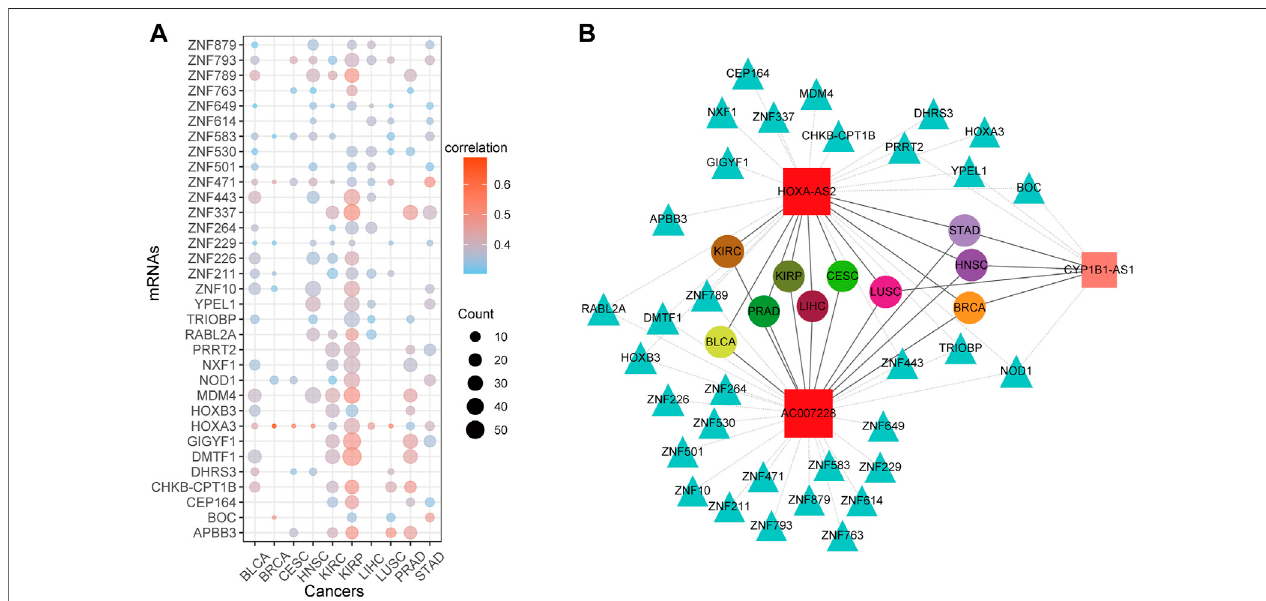
FIGURE 9 | The ceRNA network of common DMlncs of cancers (A) The ceRNA distribution of mRNAs in each cancer type. The color of the dots represents the mean of the correlation coef fi cient for the lncRNAs that form ceRNA relationships in corresponding cancer. The size of the dots represents the number of lncRNAs that have a ceRNA relationship with the corresponding mRNA in cancer (B) The ceRNA network. Square nodes represent lncRNAs, triangle nodes represent mRNAs, and round nodes represent cancer types. The size of lncRNA nodes is proportional to the number of cancer types sharing it, and nodes of different cancer types are distinguished by different colors.